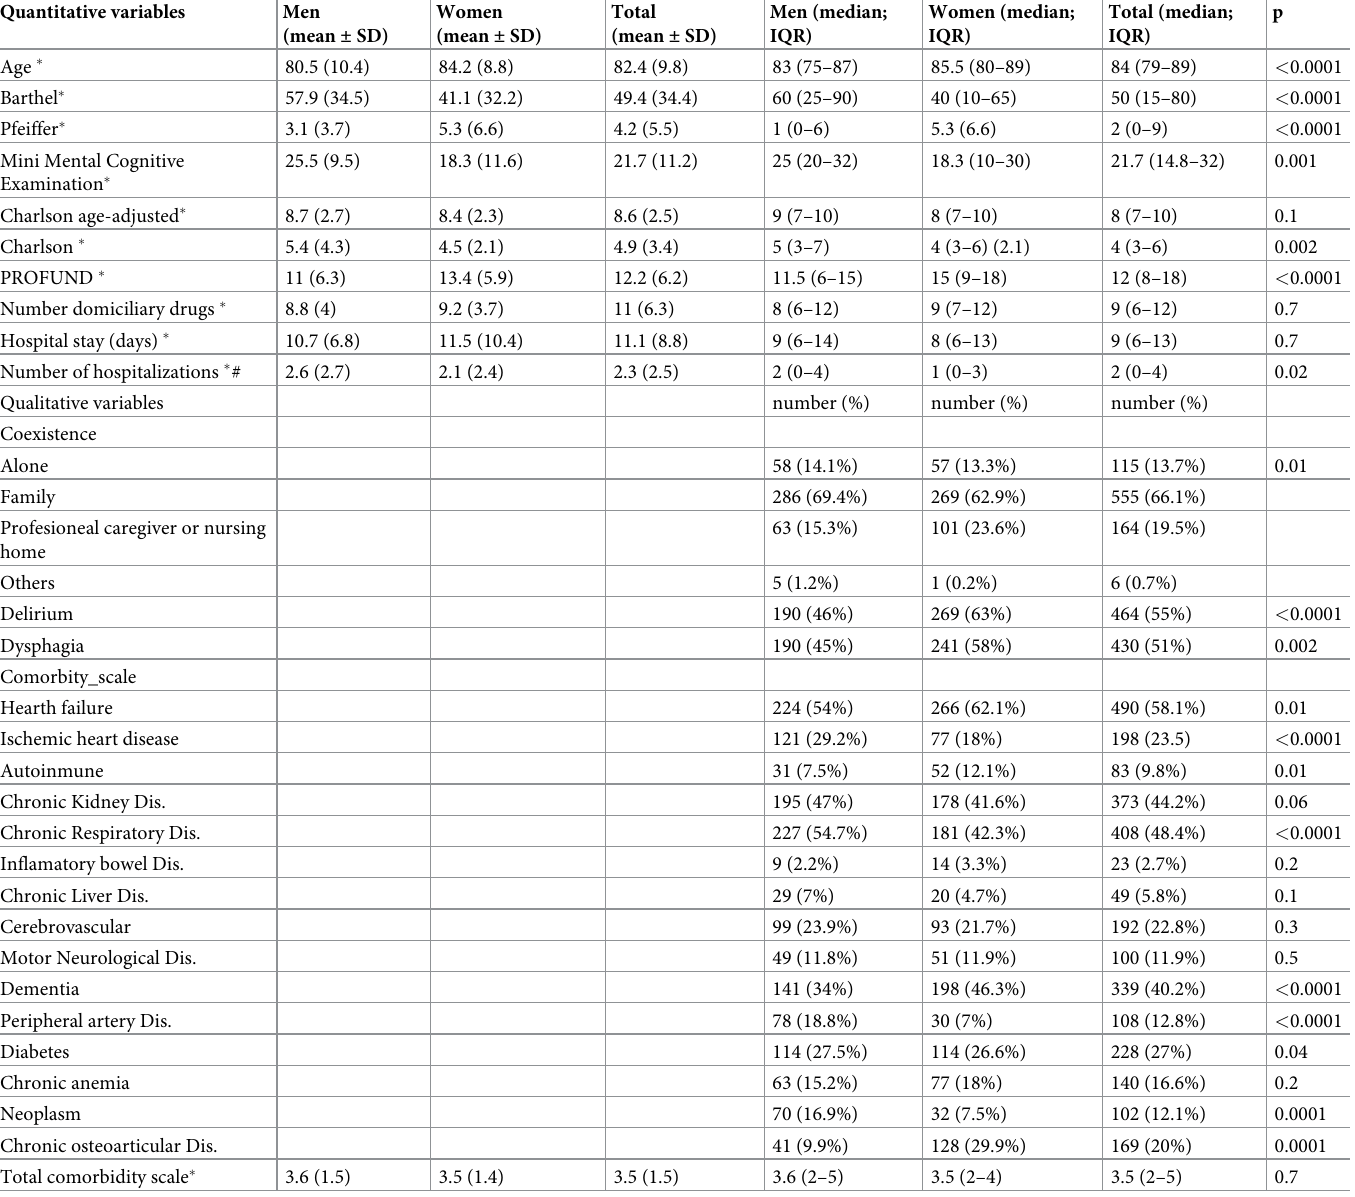
Table 1. Differences by gender in the studied